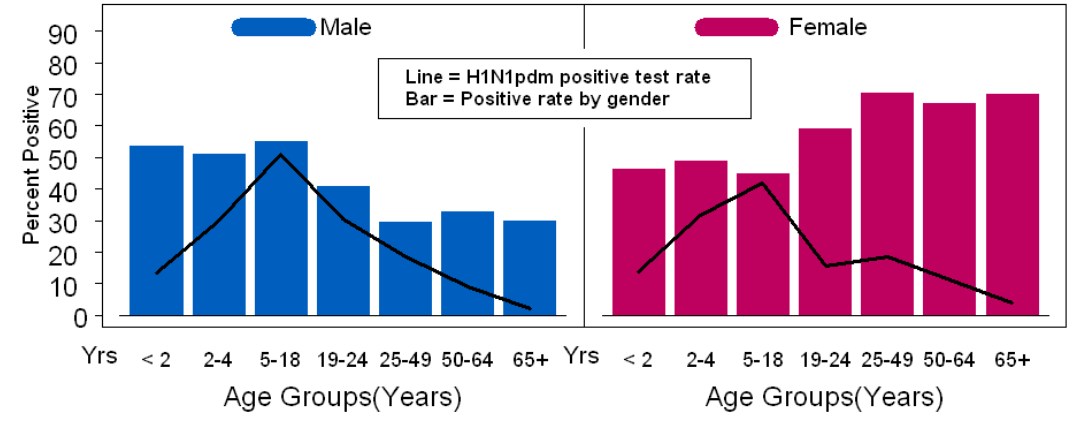
Figure 1. Age distribution of patients infected with influenza A H1N1pdm. Lines indicate H1N1pdm positive rate (e.g., number of patients positive/number of patients tested) by age group. Bars indicate the proportion of all patients positive in a given age group by gender (e.g., males plus females =